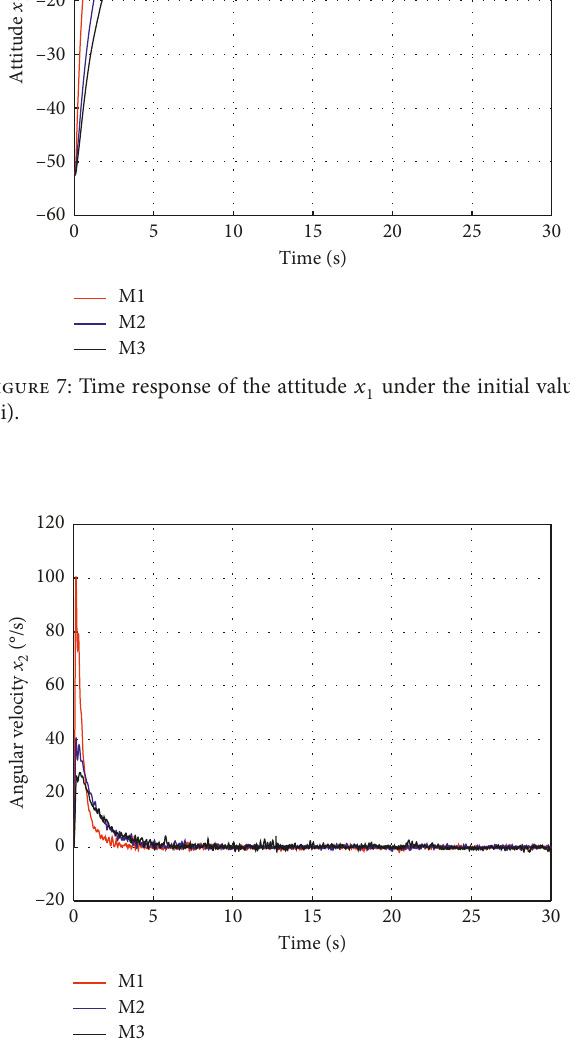
under the initial 2